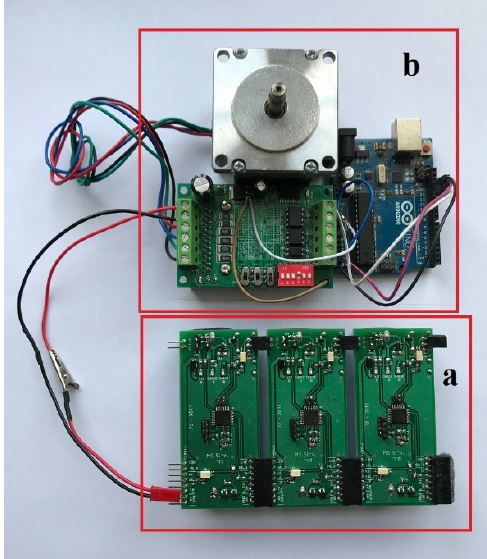
Figure 8. The FLC charge scheme.